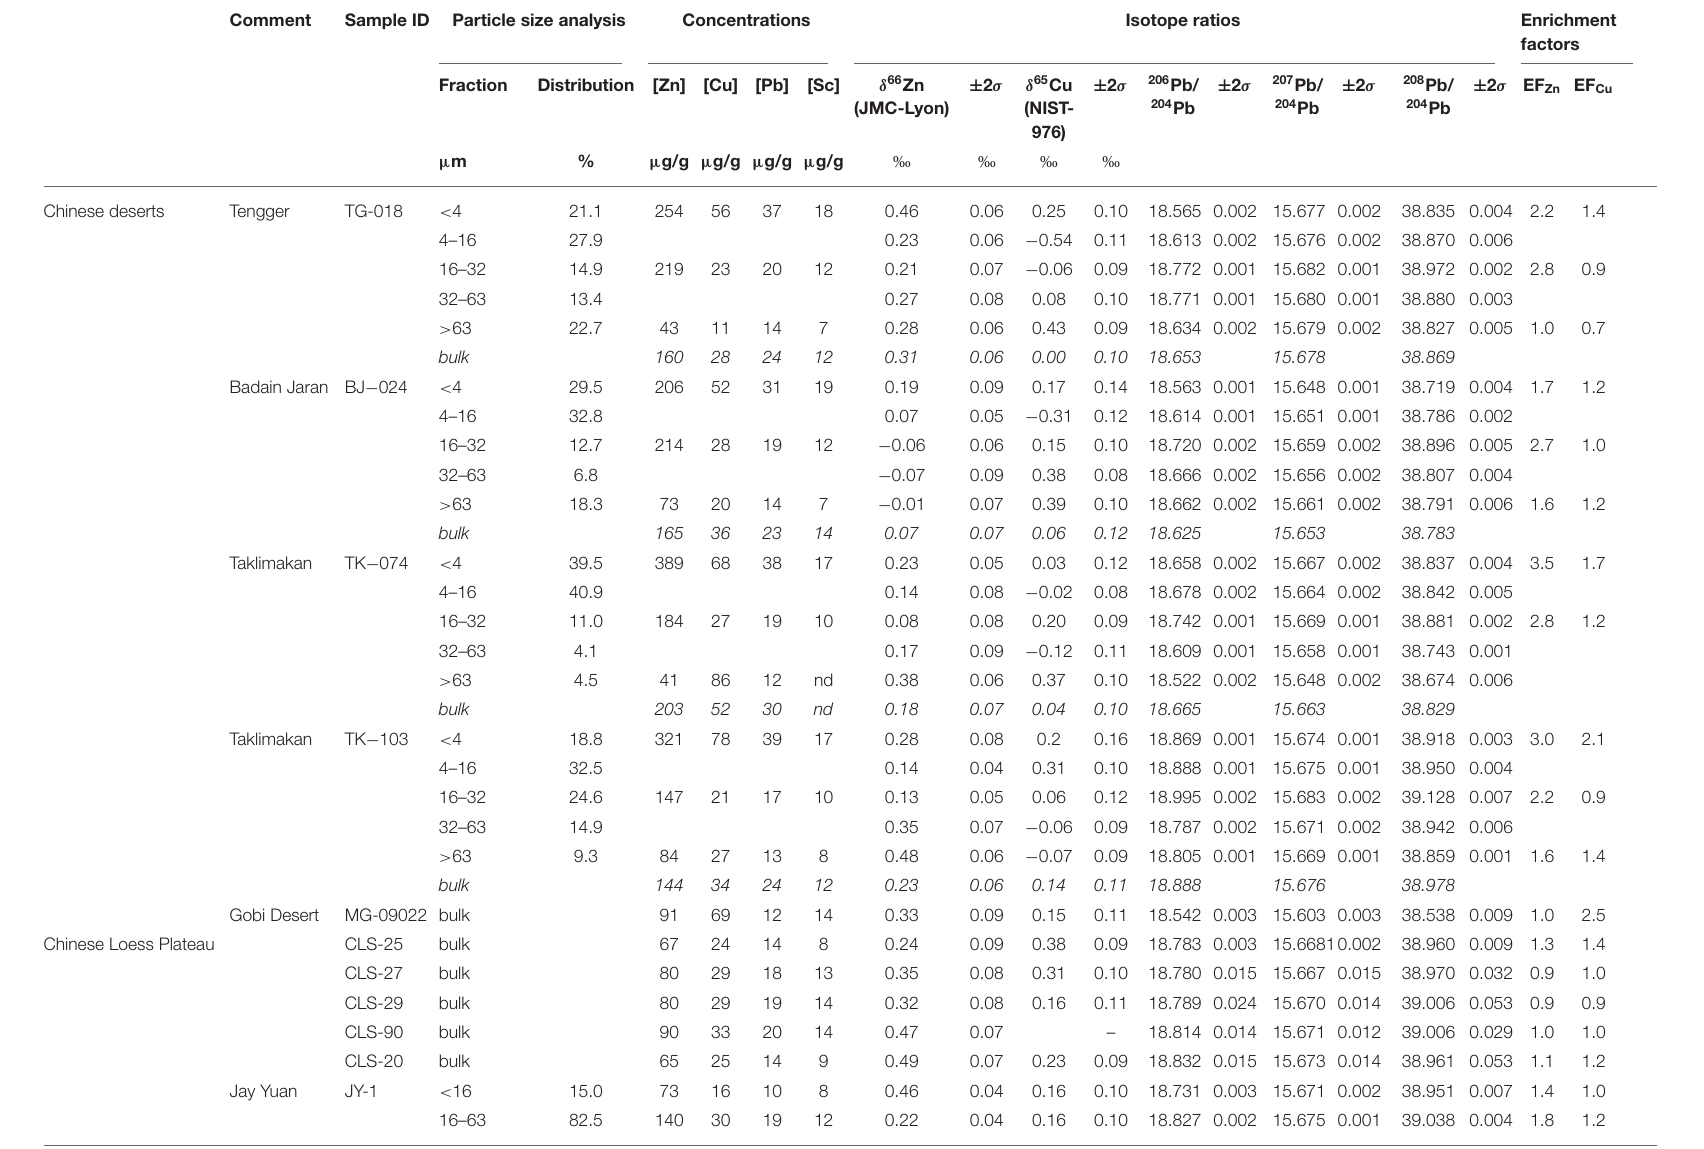
TABLE 3 | Sample origin, sample ID, particle size fraction and distribution, elemental concentration, isotope ratios, and enrichment factors for the samples analyzed in this